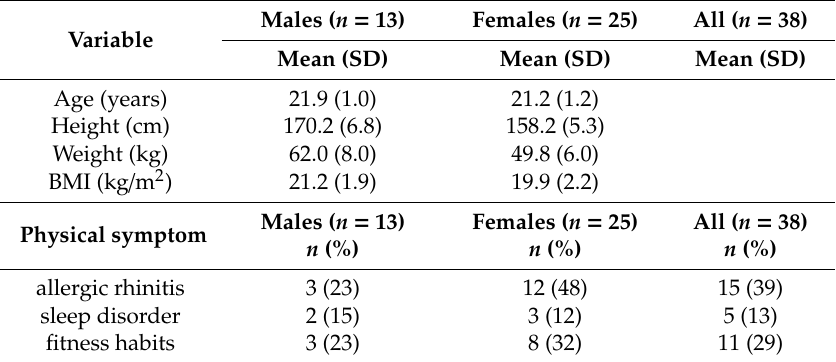
Table 1. Participants’ descriptive statistics ( n = 38).